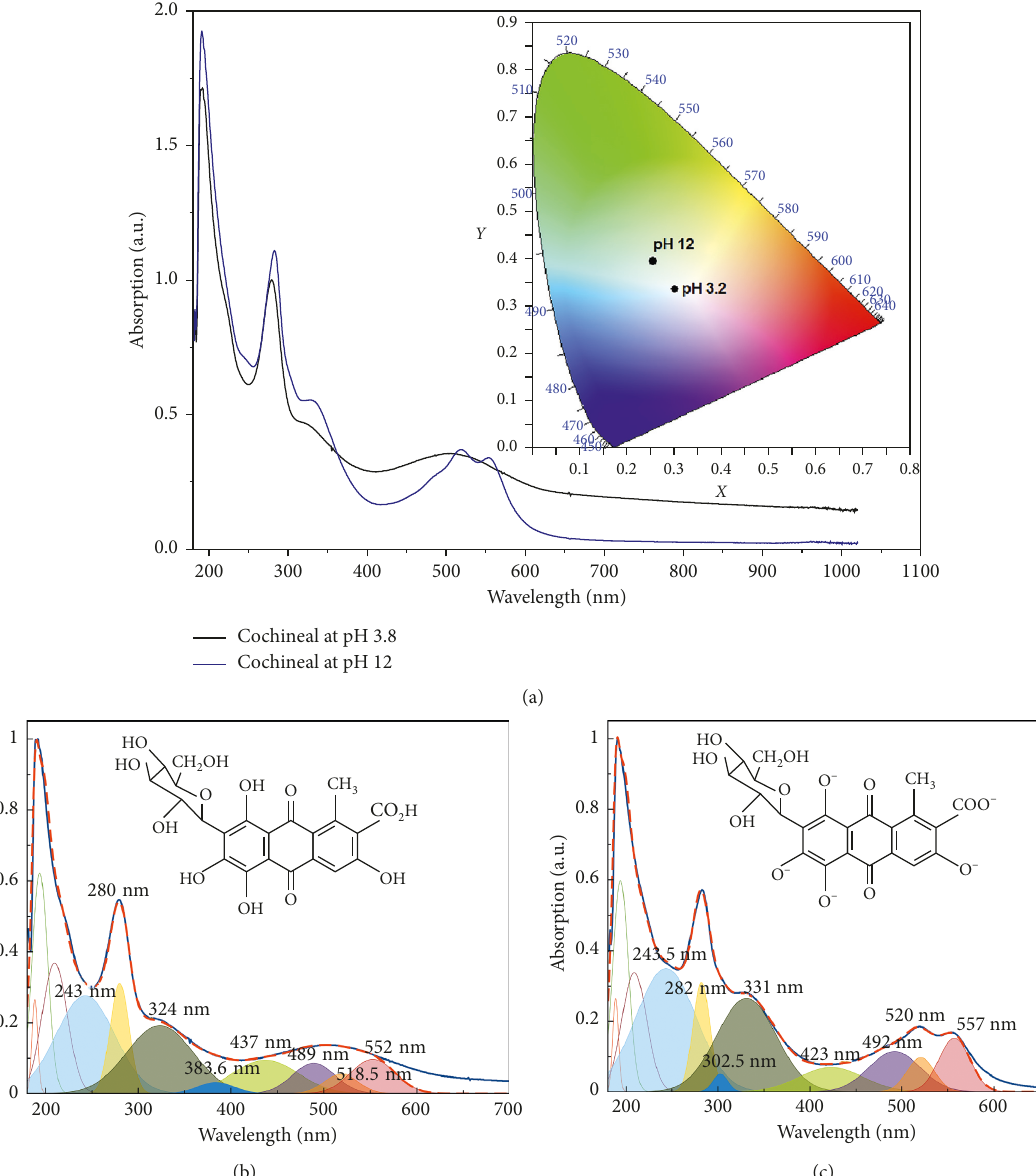
Figure 1: (a) UV-Vis spectra of cochineal pigment at pH 3.8 (black) and 12.0 (blue) with corresponding CIE chromaticity diagram (inset). Linear least-squares models (red dashed lines) of Gaussian components of cochineal pigment spectra (solid blue lines) at pH 3.8 (b) and 12.0 (c). Insets in (b) and (c) show the chemical structures of cochineal pigment at pH 3.8 and pH